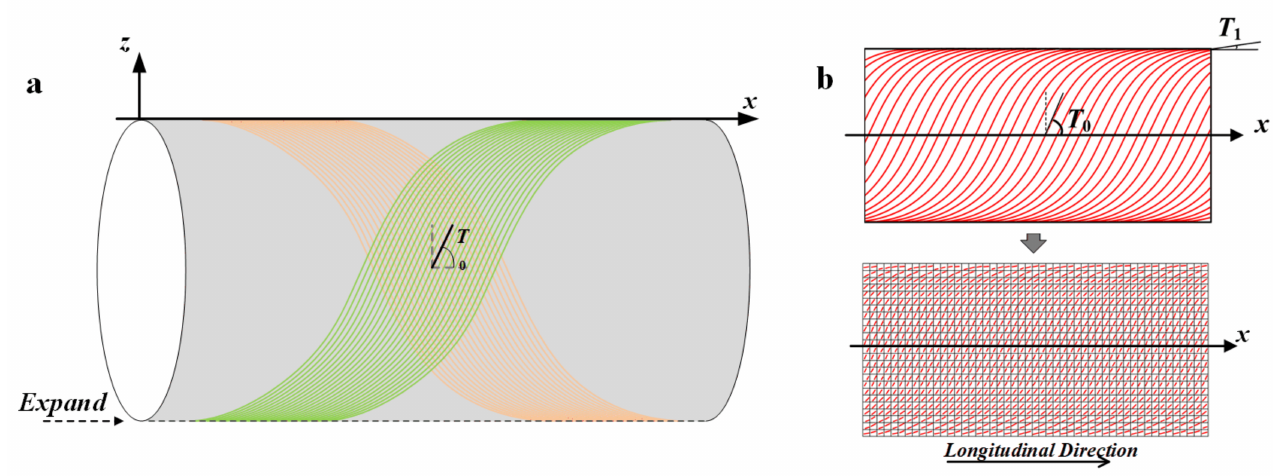
Figure 4. Fiber path diagram for a cylinder side surface: ( a ) fiber path along 3D cylinder surface and ( b ) 2D fiber path and simulation of DFE